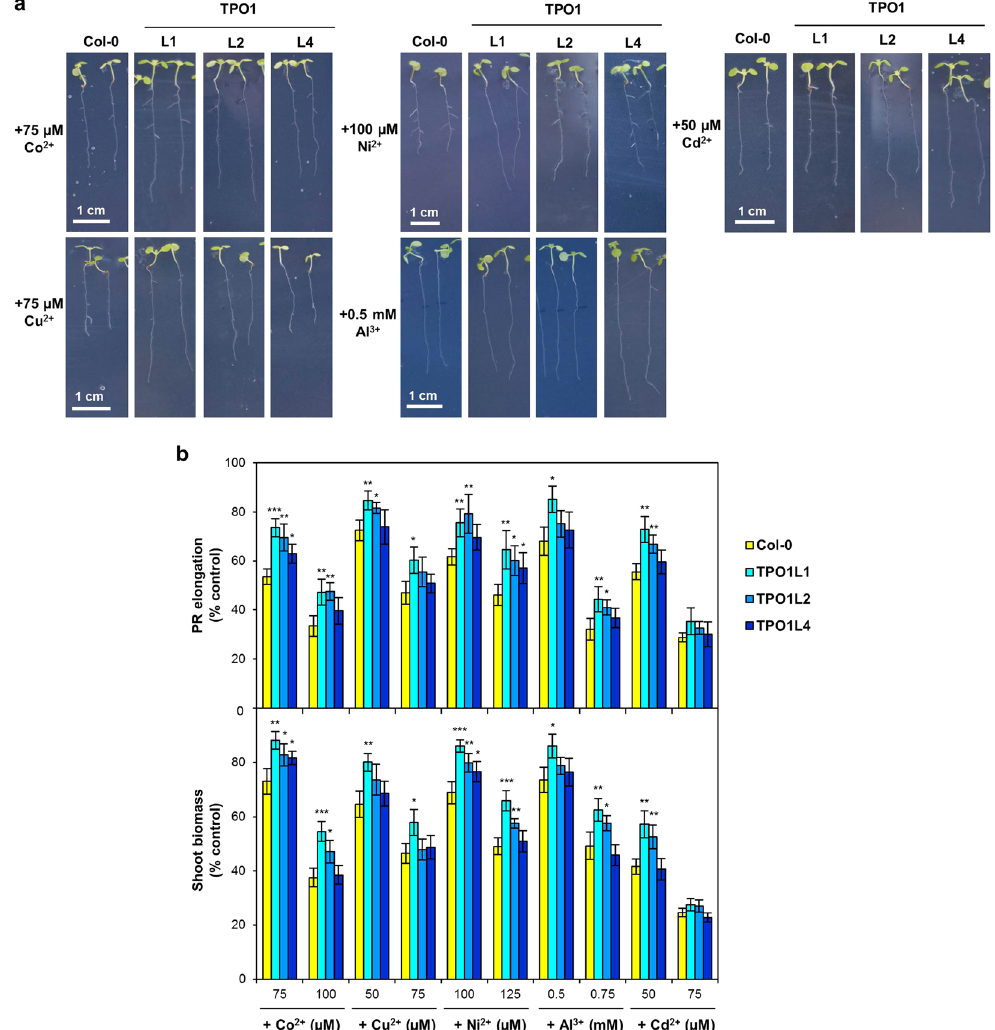
Figure 7. Effects of rhizotoxic ion challenge on transgenic Arabidopsis lines expressing the yeast Tpo1p transporter. ( a ) Representative images of 7-d old seedlings of the wild type (Col-0) and TPO1 (TPO1L1, L2, L4) transgenic lines grown on media containing Co 2 + , Cu 2 + , Ni 2 + , Al 3 + or Cd 2 + . Plant growth under control conditions is shown in Fig. 1 and Table 1. ( b ) Effect of Co 2 + , Cu 2 + , Ni 2 + , Al 3 + or Cd 2 + toxicity on PR elongation (upper panel) and shoot biomass (lower panel) of seedlings of the wild type (Col-0) and TPO1 (TPO1L1, L2, L4) transgenic lines. Values represent means ± SD ( n = 8), with similar results being obtained in three independent experiments performed with different seed batches. Asterisks denote statistically significant differences between ScTPO1 -expressing lines and the wild type ( * P < 0.05, ** P < 0.01, *** P < 0.001; Student’s t -test).